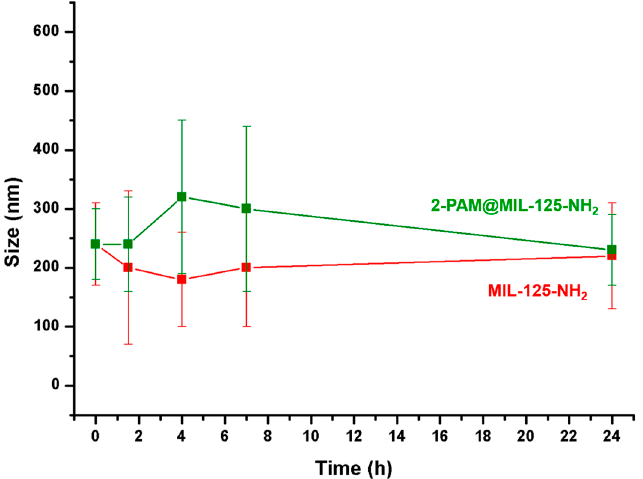
Figure 5. Variation of the particle size of MIL-125-NH 2 and 2-PAM@MIL-125-NH 2 in fetal bovine serum (FBS) supplemented with phosphate buffered saline (PBS) as a function of time.